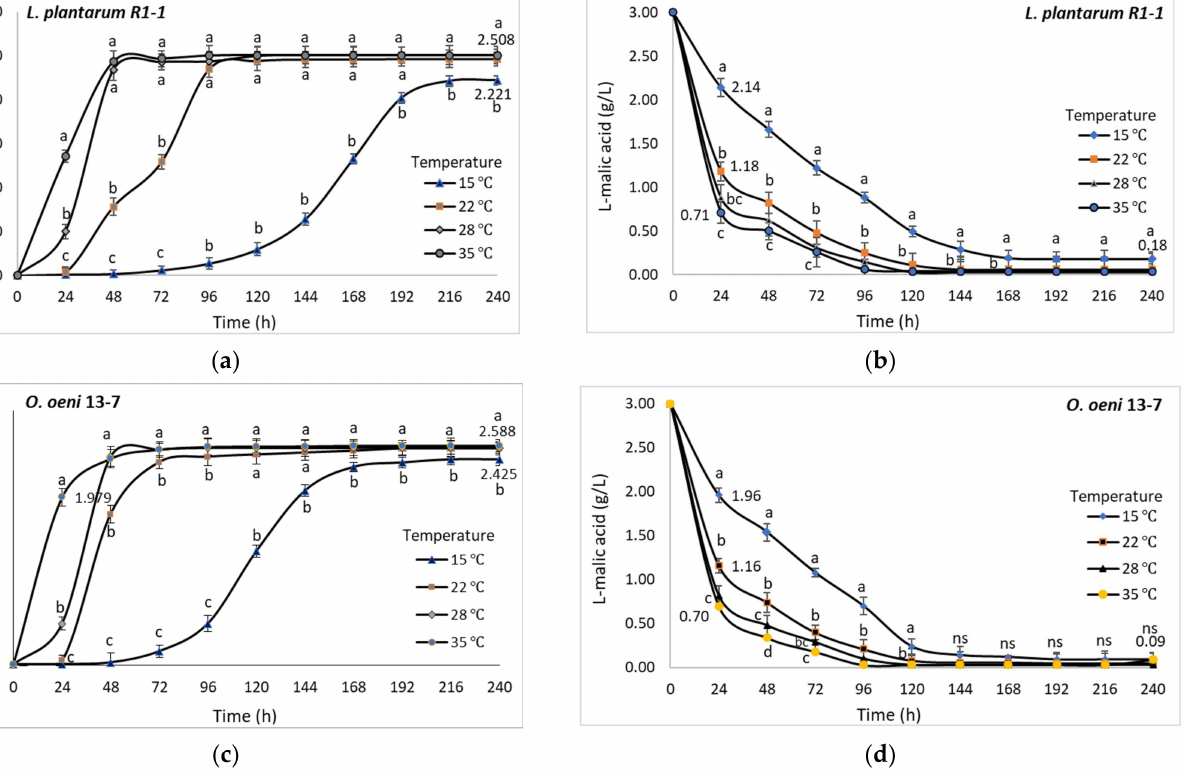
Figure 9. Influence of incubation temperature on cell development and malic acid metabolism of Lactobacillus plantarum strain R1-1 ( a , b ) and Oenococcus oeni strain 13-7 ( c , d ). Cells incubated in MRS- TJ broth (10 6 CFU/mL) at different temperatures. Each value is the mean of a triplicate experiment, error bars indicate standard deviation ( ± ). In all cases the standard deviation was lower than 10% of the mean value. Different letters within the same column indicate significant differences between data ( p <